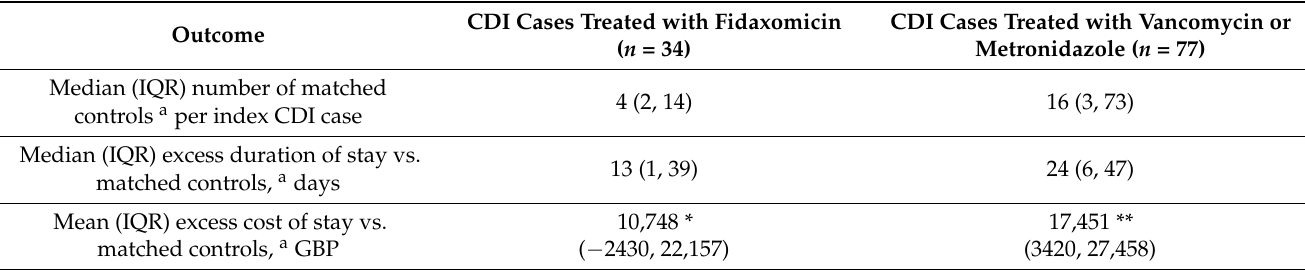
Table 3. Excess costs (vs. matched controls) of CDI